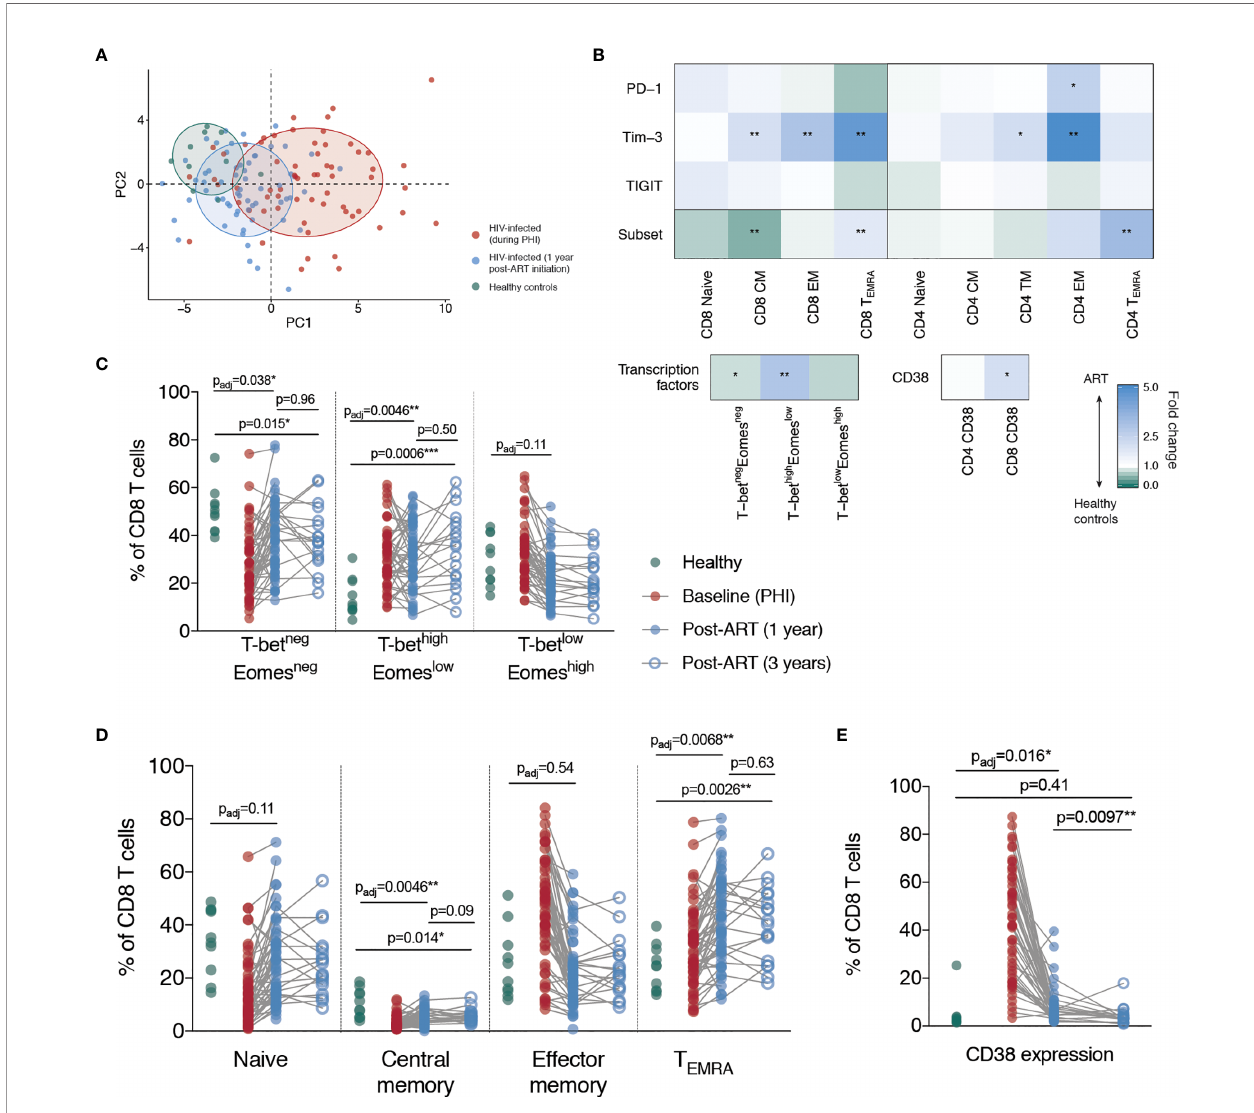
FIGURE 3 | Partial but incomplete restoration of T cell phenotype following ART initiation during primary HIV infection. (A) Principle component analysis of all immune parameters measured here; plotted are the fi rst two principle components (PC1 against PC2). For the construction of this PCA, missing immunologic measures were imputed using MissForest (36). Each point represents an individual from one of the following groups: healthy controls (green), primary HIV infection (red) and 1-year following ART initiation (blue). Ellipses have been added to aid in visual comparison and encompass 60% of values for each group. (B) Summary of comparisons between healthy controls and individuals following 1 year of ART. Blocks, each corresponding to an immune parameter, are shaded according to the fold difference between ART-treated individuals relative to healthy controls. The subset refers to the frequency of that memory subset as a proportion of bulk T cell pool, and the PD-1, Tim-3 and TIGIT rows refer to the percentage expression of those markers on that memory subset. Groups were compared using Mann- Whitney tests and adjustment of p-values for multiple comparisons was performed across all comparisons presented here to control the false discovery rate; asterisks correspond to the adjusted p-value. (C) T-bet and Eomes expressing CD8 T cells subsets. (D) CD8 T cell memory subsets. (E) CD38 expression on CD8 T cells. For (C – E) data are shown for healthy controls (n = 10, green), during PHI (C and E n = 54, D n = 60, red), following 1 year of ART (C and E n =6 0, D n = 58, blue closed circles) and 3 years of ART (n = 18, blue open circles). Comparisons between healthy controls and 1 year values were performed as in B (asterisks and listed p-values correspond to the adjusted p-value); additional tests involving 3 year timepoint are only shown for groups for which p < 0.05 in (B) . Other groups were compared using Mann-Whitney tests (unadjusted); the PHI group is shown as a visual aid and was not included in formal comparisons. For comparisons * indicates p < 0.05; ** indicates p < 0.01; *** indicates p <